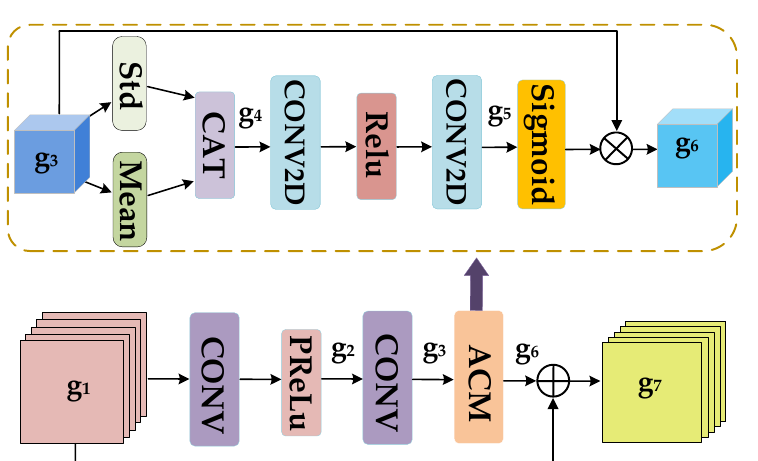
Figure 3. The overall structure of FCM, referred to as FCM. Where the black arrows indicate the transfer information stream. ⊕ and ⊗ denote feature fusion and elements multiplication,